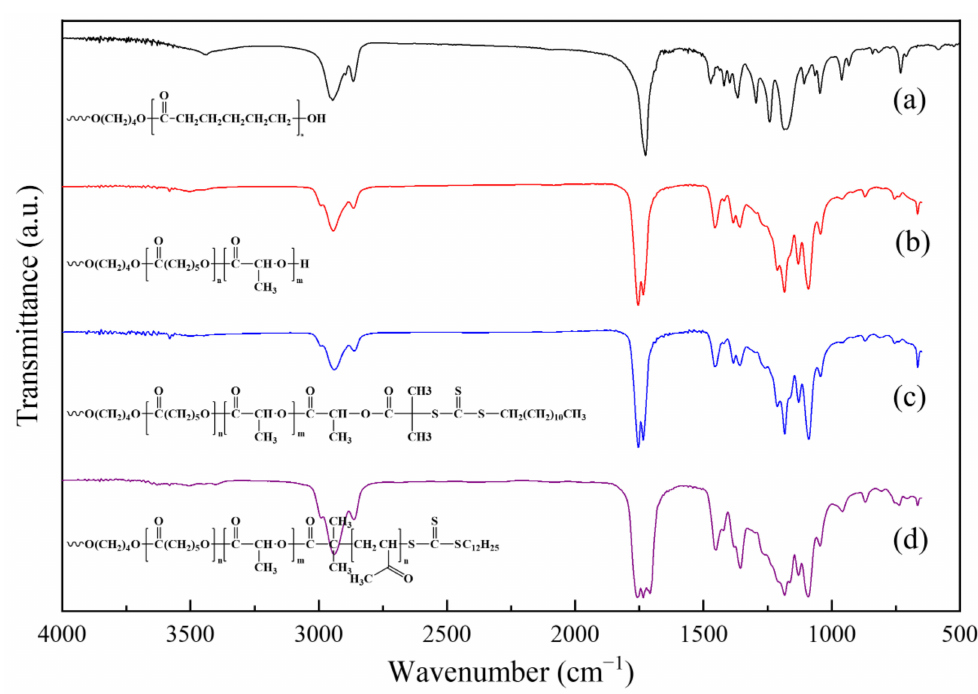
Figure 1. FT-IR spectra of ( a ) PCL, ( b ) PCL-b-PLA, ( c ) PCL-b-PLA-TTC, and ( d ) PCL-b-PLA-b-PMVK.